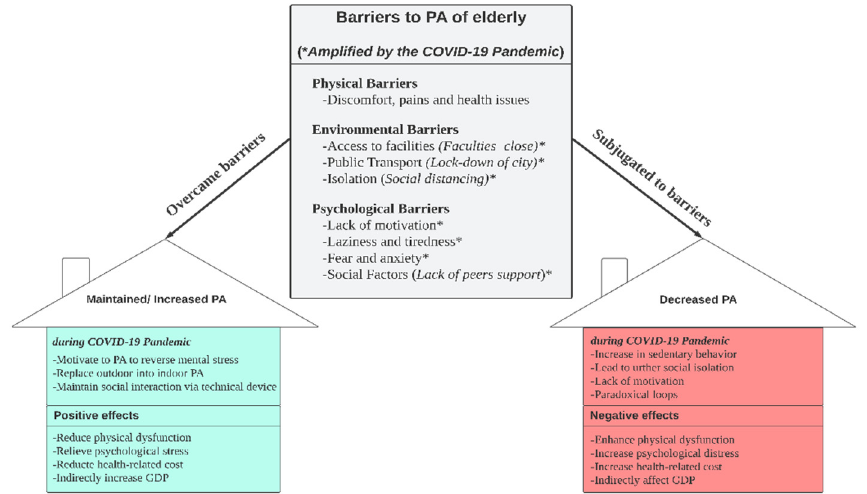
Figure 1. Summary of the barriers to physical activity of older adults amplified by the COVID-19 pandemic and the relevant effects to elderly’s health and economy.